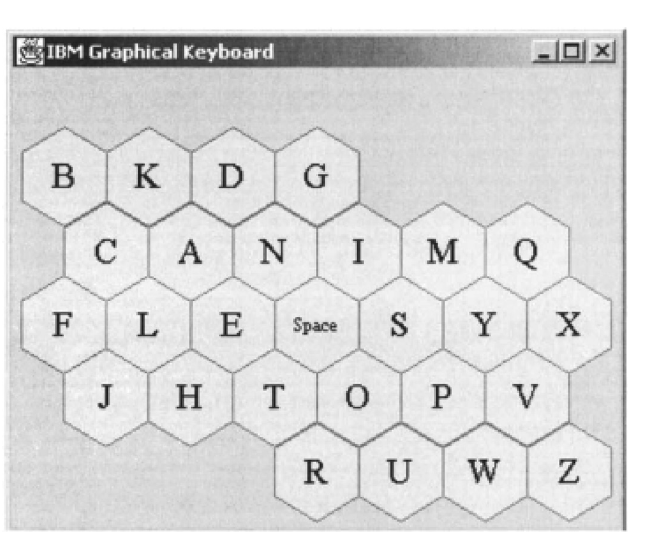
Figure 4. ATOMIK Keyboard Layout